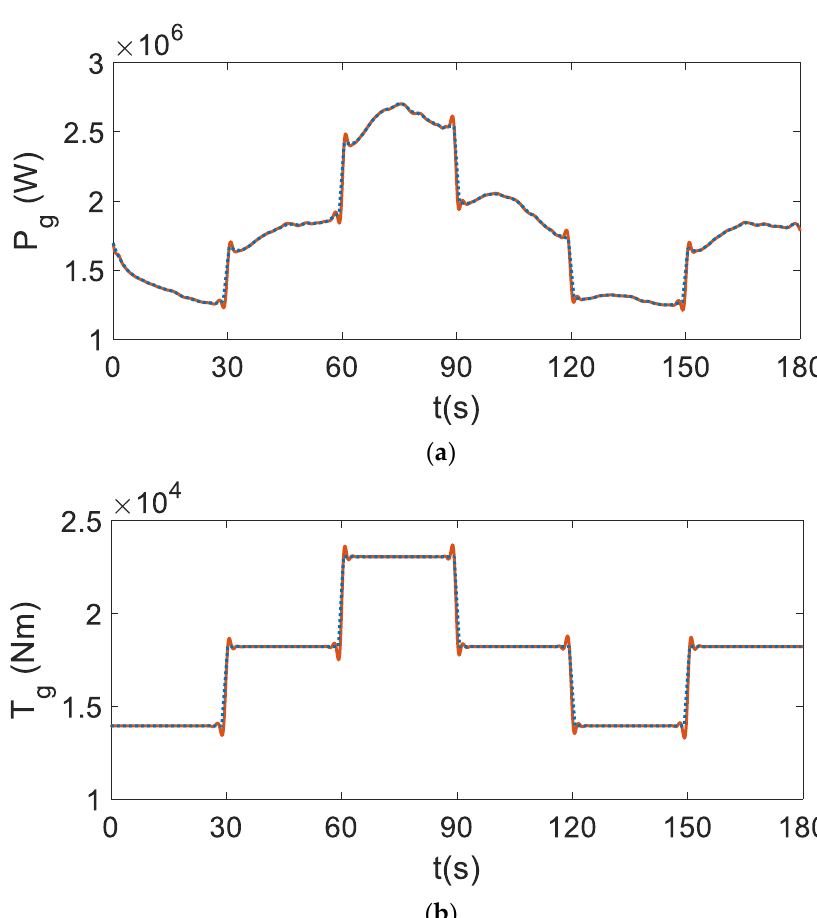
Figure 8. ( a ) Output power P g and ( b ) generator torque T g of WPGS for the robust MPC (red solid line) and stochastic MPC (blue dotted line) in the low wind speed region with severe turbu- lence.